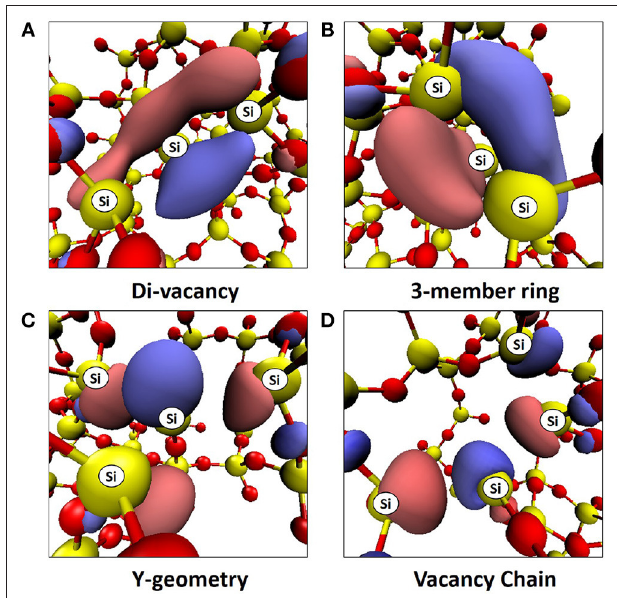
FIGURE 2 | Typical LUMOs from (A) Oxygen di-vacancy in a-SiO 2 , (B) 3-member ring type tri-vacancy in a-SiO 2 , (C) Y-geometry type tri-vacancy in a-SiO 2 , (D) Vacancy chain type tri-vacancy in a-SiO 2 . Positive and negative iso-surfaces are shown in blue and red with iso values of ± 0.05, respectively. The Si atoms belonging to each vacancy cluster are labeled.